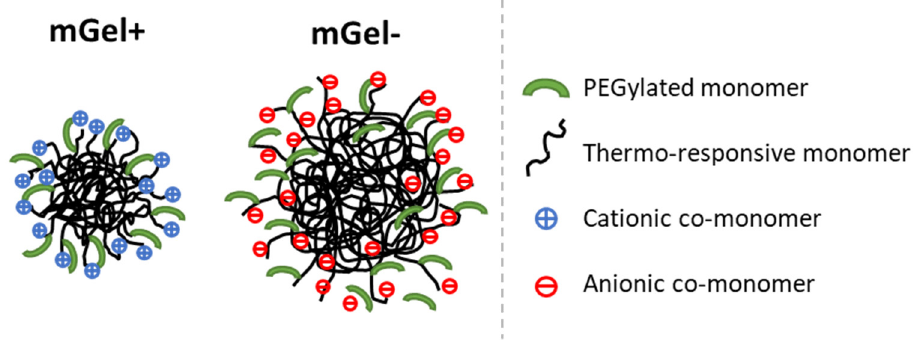
Figure 1. Schematic diagram of the microgel particles synthetized following the procedure detailed in Section 4.2. Details on the components are displayed in Table 1.